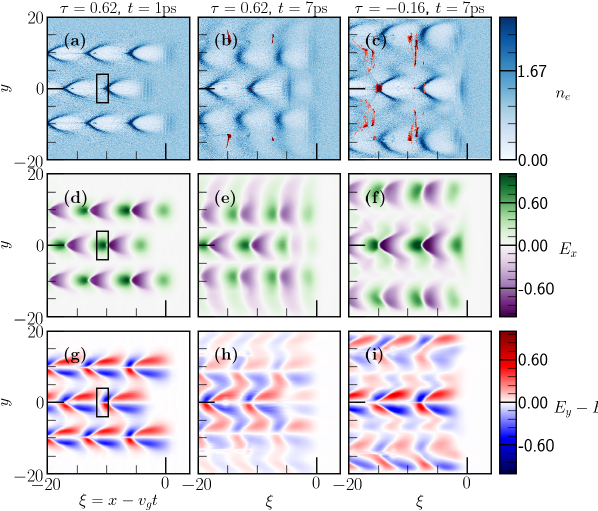
FIG. 4. Simulation results of (a) – (c): electron density distribu- tion n (positrons are colored in red); (d) – (f): accelerating field e E ; and (g) – (i): focusing field ð E x entry of the plasma region) with τ ¼ 0 . 62 [(a), (d), (g)] and t ¼ 7 ps (near the exit of the plasma region) with τ ¼ 0 . 62 [(b), (e), (h)] and τ ¼ − 0 . 16 [(c), (f), (i)].